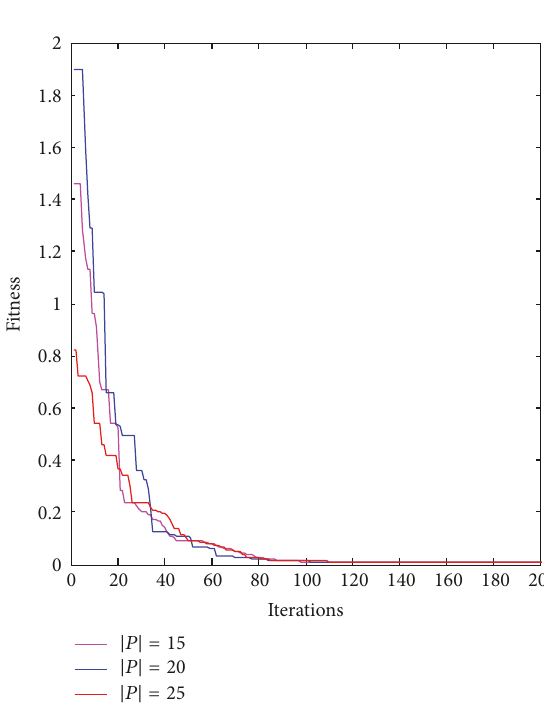
Figure 13: Convergence of g14 ( m = 40).